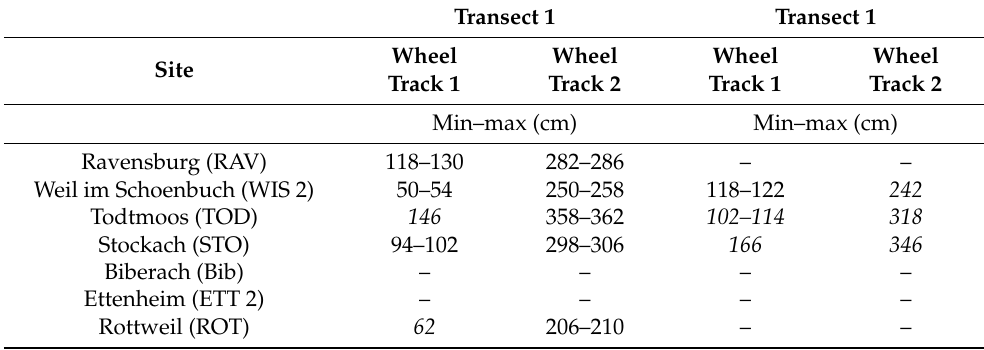
Table A1. Location of modelled fine root density; the five depth layers were located at the same horizontal grid cell position. Minima: The interval represents the range of horizontal grid cell positions for the minima in the first five grid layers at the transects of the investigation sites. Skid trail locations with identical minima in all of these layers are printed in